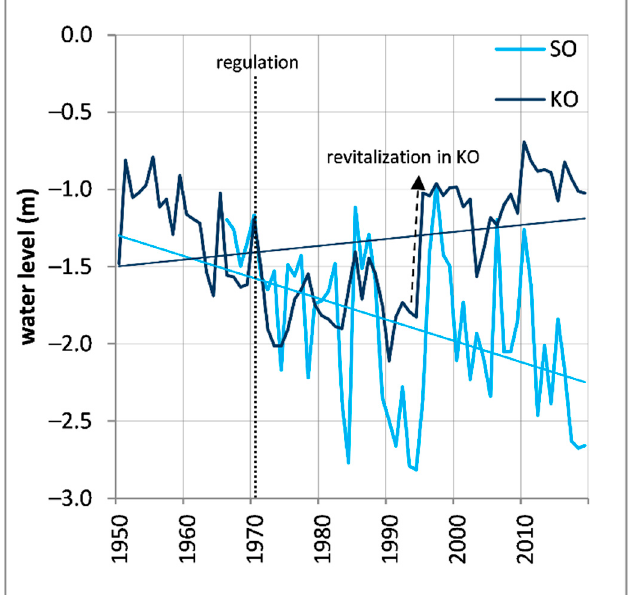
Figure 2. March–September average water level fluctuations at studied sites (SO and KO) with their linear trends represented by straight lines. The dotted line shows the date when river regulation started, while dashed arrows show the start of river revitalization at the KO site, followed by increase of the ground water level (data source: Czech Hydrometeorological Institute, Brno).